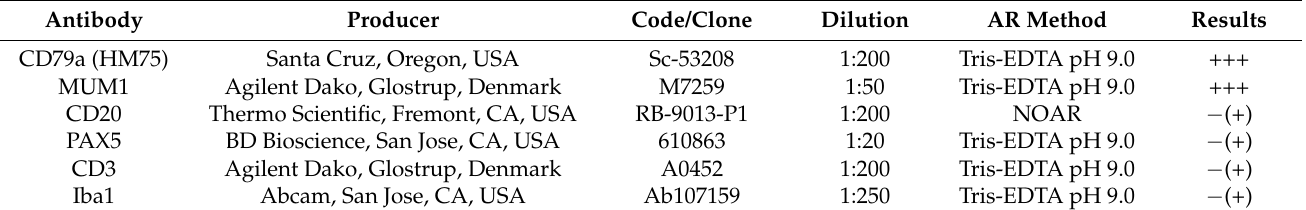
Table 2. Antibody table used in a case of cutaneous non epitheliotropic B-cell lymphoma (CNEBL) vs. multiple cutaneous plasmacytosis (CP) in a dog. Details of sources, concentrations, and antigen retrieval methods of antibodies used for immunochemistry in this study are described. NOAR: no antigen retrieval. Cell type expression: CD79A Mature B cells/plasma cells; MUM1 plasma cells; CD20 pre-B cells and mature B cells (<20% plasma cells); PAX5 B cells; CD3 mature T cells; IBA1 histiocytic/dendritic cells. Results: +++: the majority of neoplastic cells were positive for the investigated marker. − (+): neoplastic cells were negative but scattered immunoreactive round or dentritic cells, interpreted as inflammatory cells, were note intermixed with neoplastic cells.